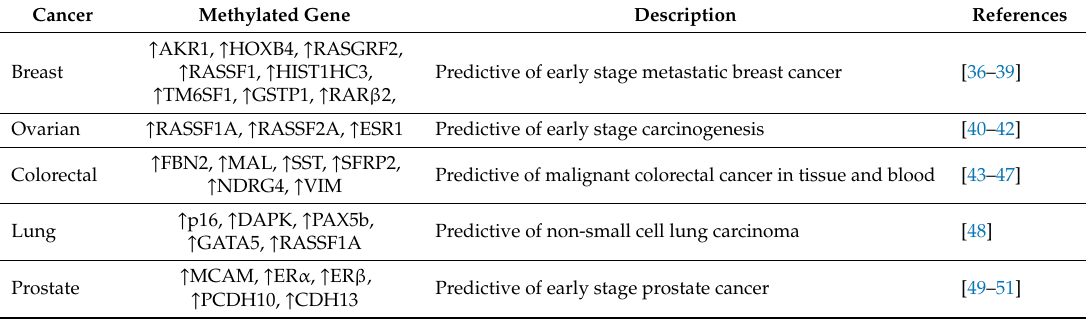
Table 1. Summary of DNA methylation biomarkers in five common cancers that is approved for clinical